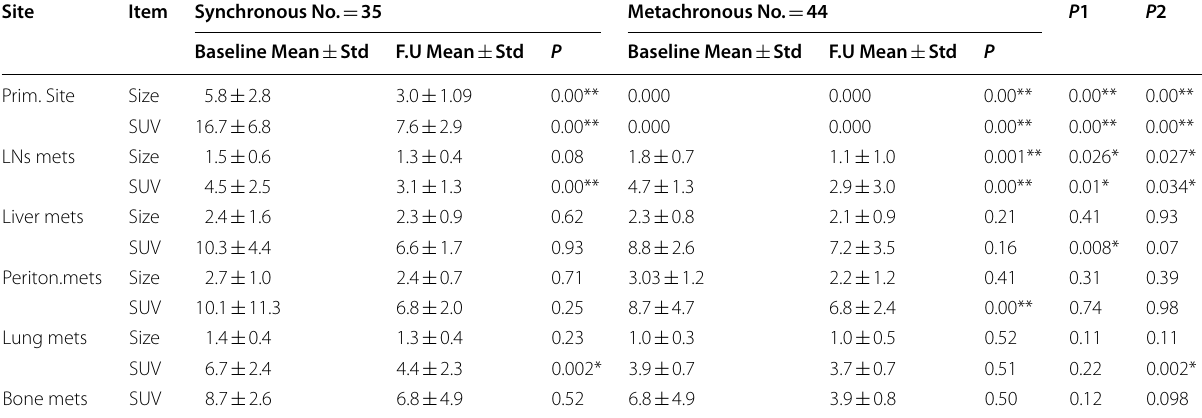
Table 3 Comparison between patients with synchronous and metachronous metastases regarding lesions size and SUV on 18F-FDG PET/CT study